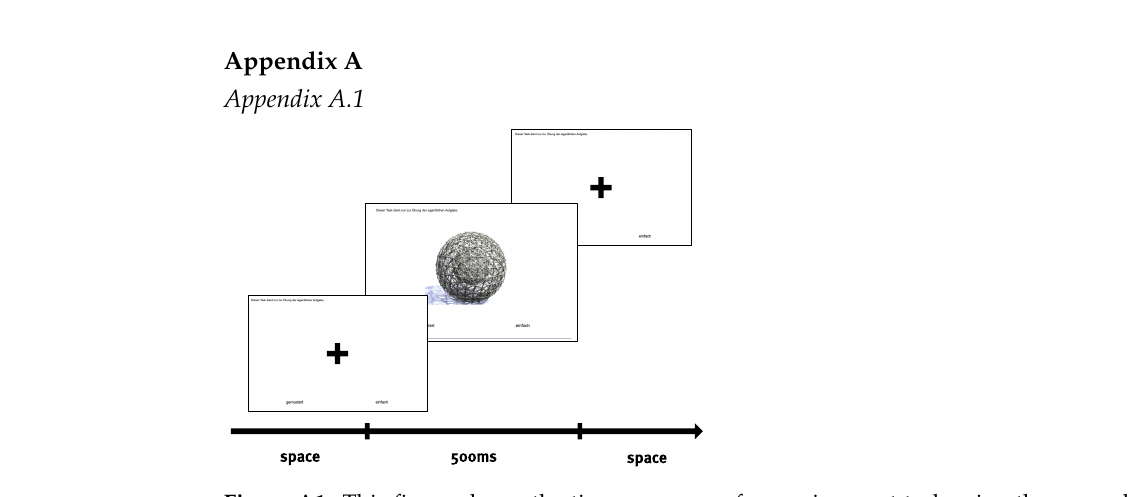
Figure A1. This figure shows the time sequence of an assignment task using the example of the exercise task.